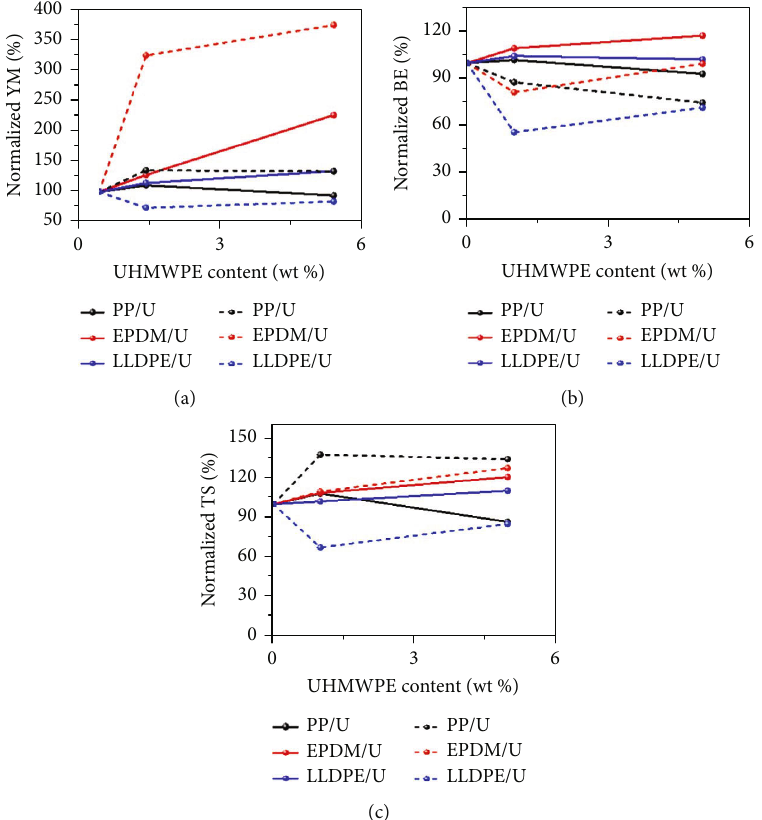
Figure 12: Normalization mechanical properties of three kinds of samples blended with low-entanglement UHMWPE (solid line) and high- entanglement UHMWPE (dashed line): (a) Young ’ s modulus, (b) breaking elongation, and (c) tensile